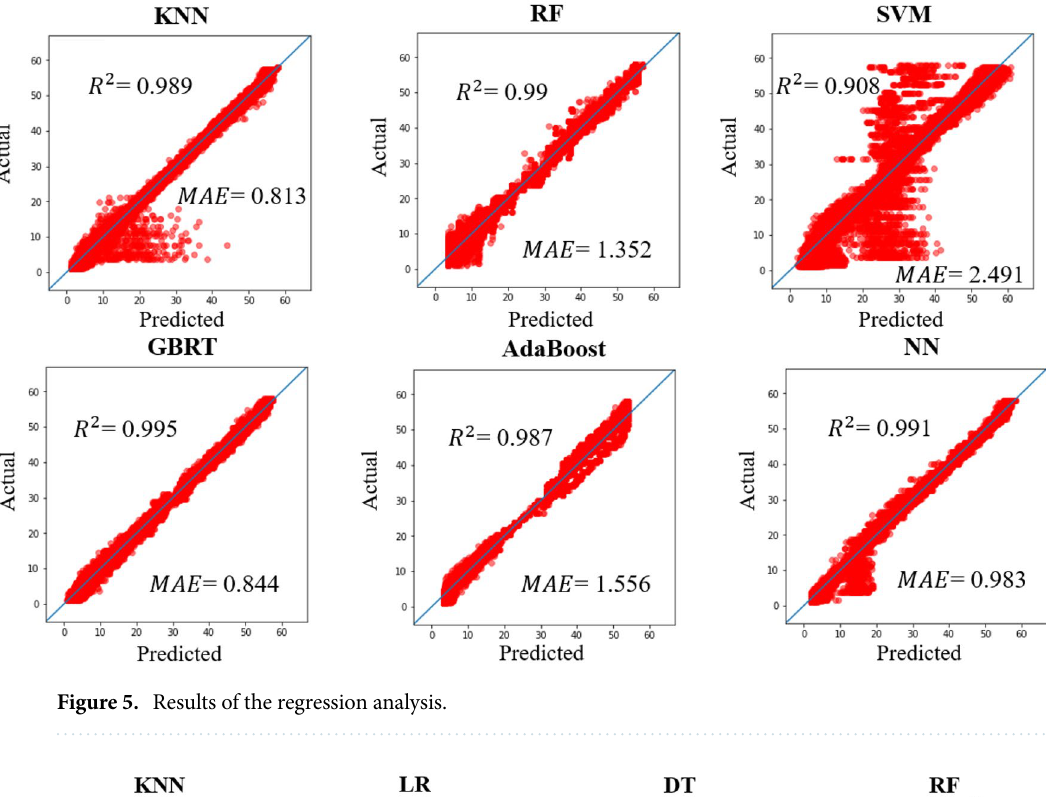
Figure 5. Results of the regression analysis.